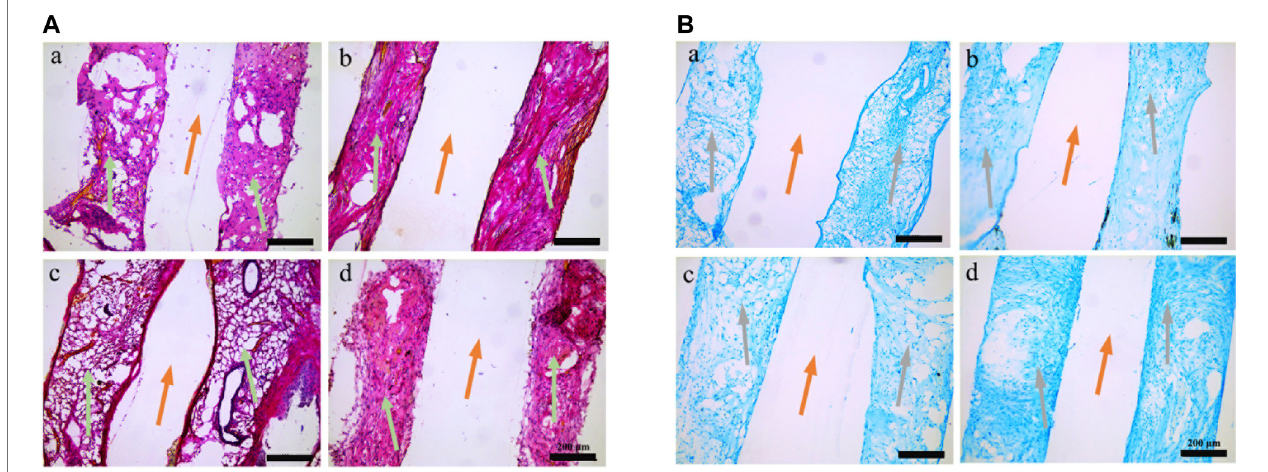
FIGURE 8 | Histological analysis of the scaffolds retrieved from nude mice. (A) Picrosirius red staining. (B) Alcian blue staining. (a) PU-dECM; (b) PDA-PU- dECM; (c) PCL/PU-dECM; (d) PDA-PCL/PU- dECM. Orange arrows, 3D printed scaffolds framework lines; green arrows, collagen positively stained red with Picrosirius red; grey arrows, GAG positively stained blue with Alcian